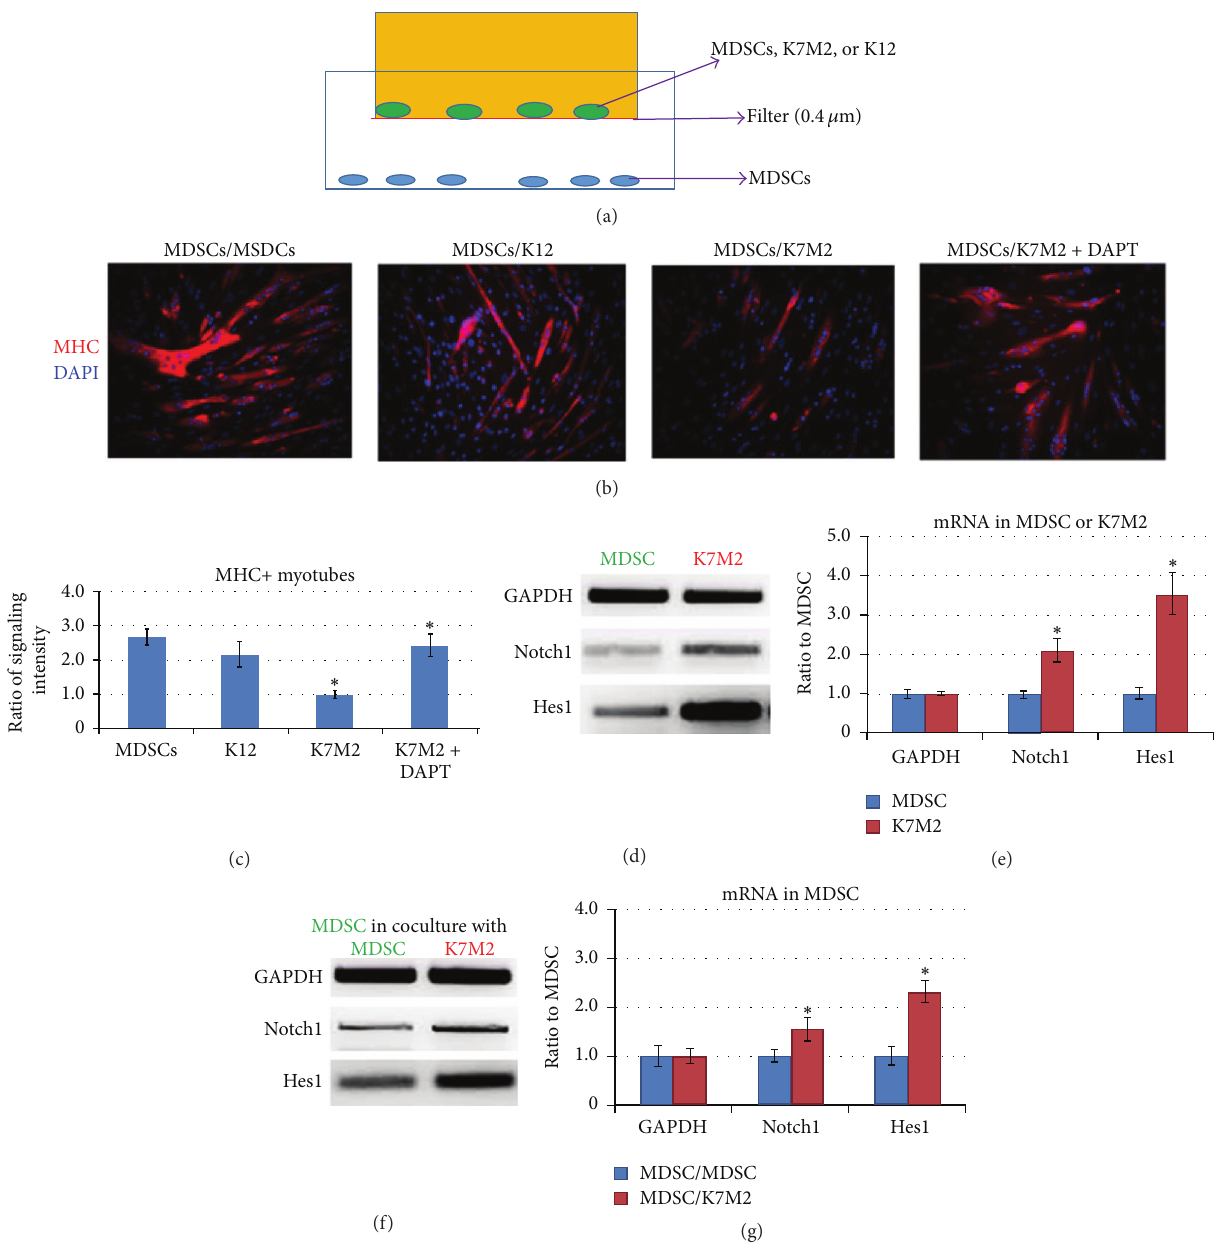
Figure5:CocultureofK7M2cellsandMDSCs(fromnormalmuscle)resultedinrepressedmyogenesisofMDSCsandupregulatedexpression of Notch genes. (a) The transwell system used in this study, including the upper chamber seeded with MDSCs, K7M2 cells, or K12 cells on the cell nonpermeable filter (0.4 𝜇 m) and the lower chamber seeded with MDSCs. (b) Myogenesis (myotube formation) of cocultured MDSCs was measured by immunostaining of myosin heavy chain (MHC). K7M2 cells repressed the myogenesis potential of MSDCs, while the coadministration of DAPT could rescue the repressed myogenesis. (c) Ratio of MHC+ myotubes formed by cocultured MDSCs. 𝑁 = 3 replicates for each group. (d) Semiquantitative PCR revealed higher mRNA levels of Notch1 and Hes1 genes in K7M2 cells, compared to MDSCs. (e) Differential expression of Notch genes in K7M2 cells versus MDSCs. (f) Semiquantitative PCR revealed higher mRNA levels of Notch1 and Hes1 genes in MDSCs cocultured with K7M2 cells, compared to MDSCs cocultured with MDSCs. (g) Differential expression of Notch genes in MDSCs/K7M2 versus MDSCs/MDSCs. “ ∗ ” in the bar chart indicates 𝑃 < 0.05